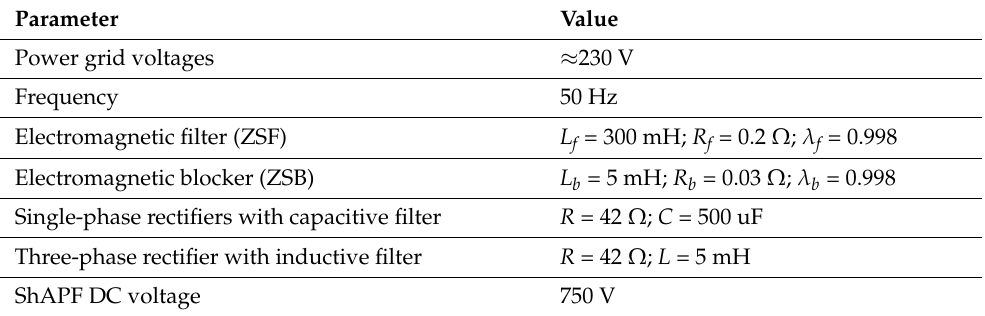
Table 1. Simulated system